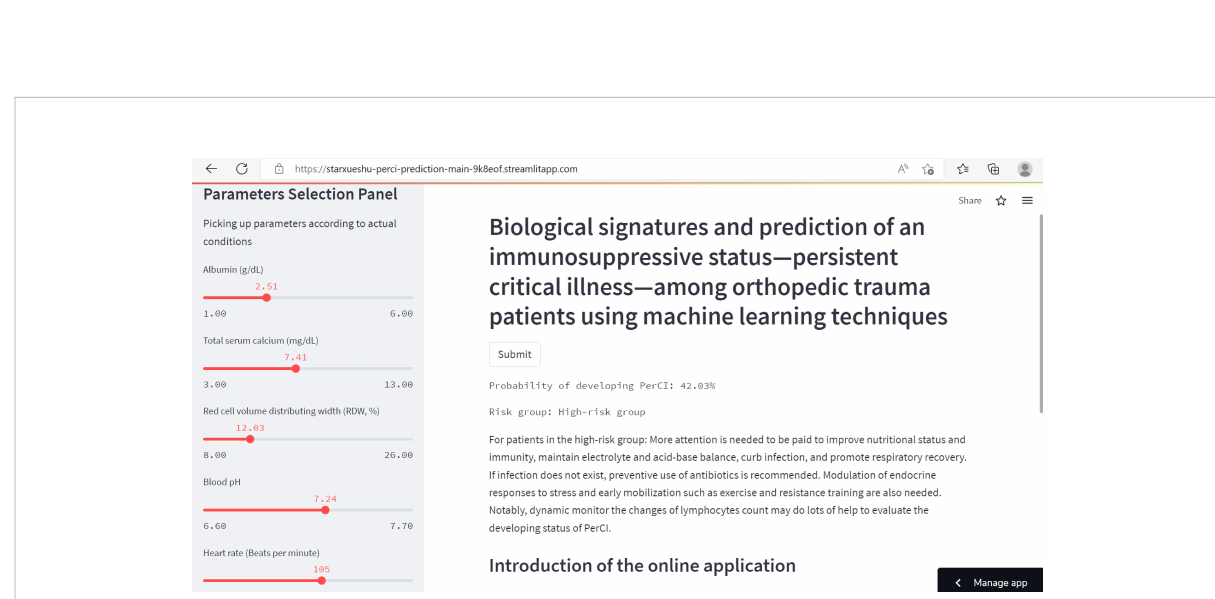
FIGURE 9 The partial interface of the online application. The left part shows a panel on selection of parameters. The right part shows predicted probability of developing PerCI, individualized preventive strategies, risk strati fi cation system, and introduction of the